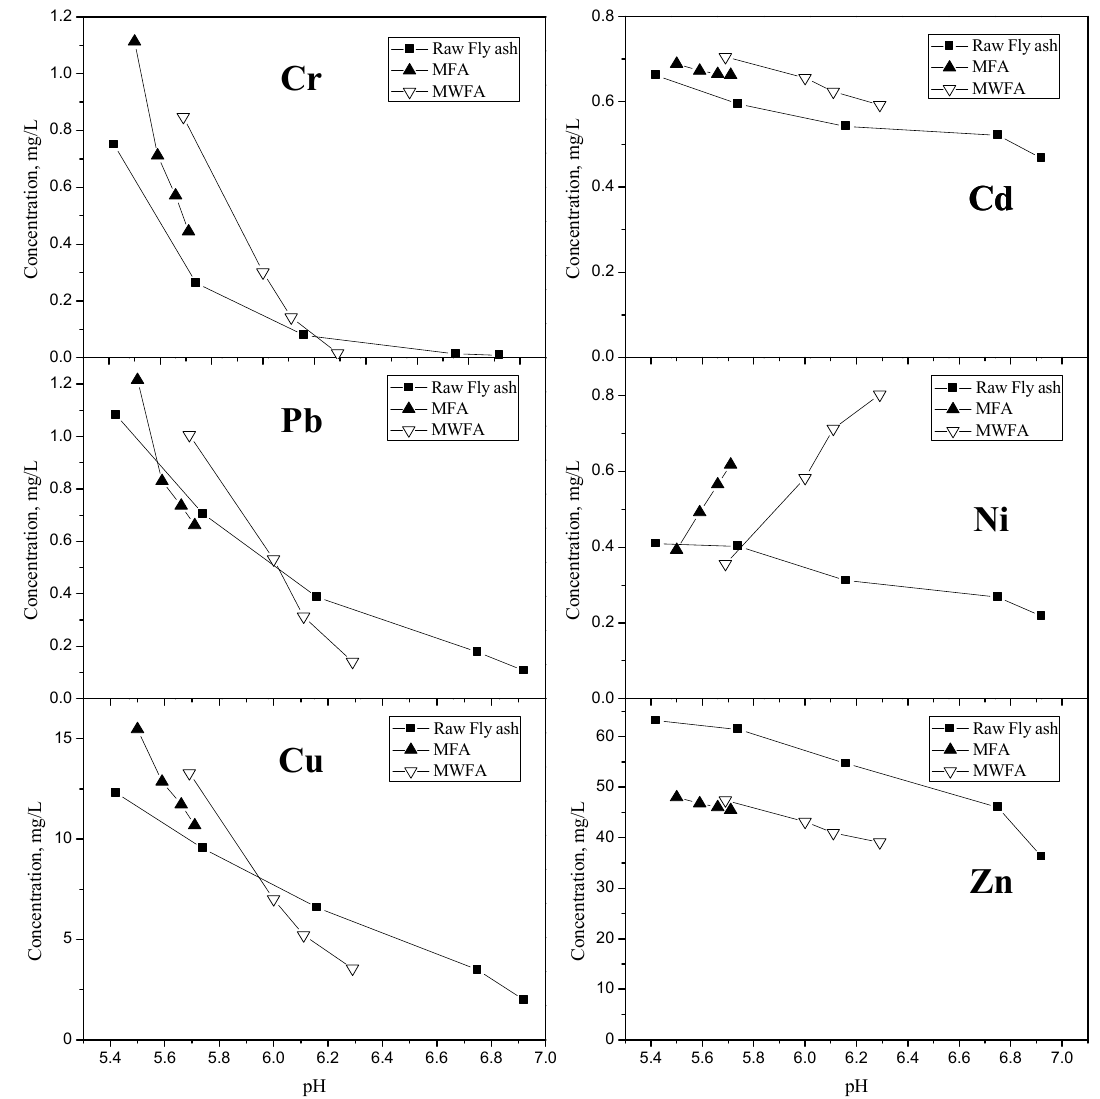
Figure 7. Evolution of leaching concentration vs. pH for raw fly ash, MFA, and MWFA.